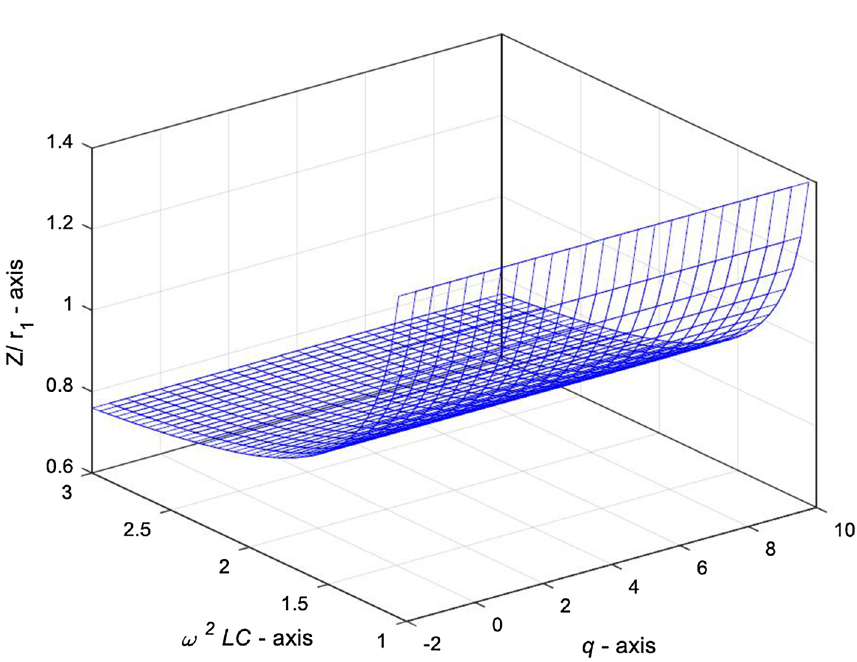
Figure 6. 3D graph of complex impedance Z 1 . q =